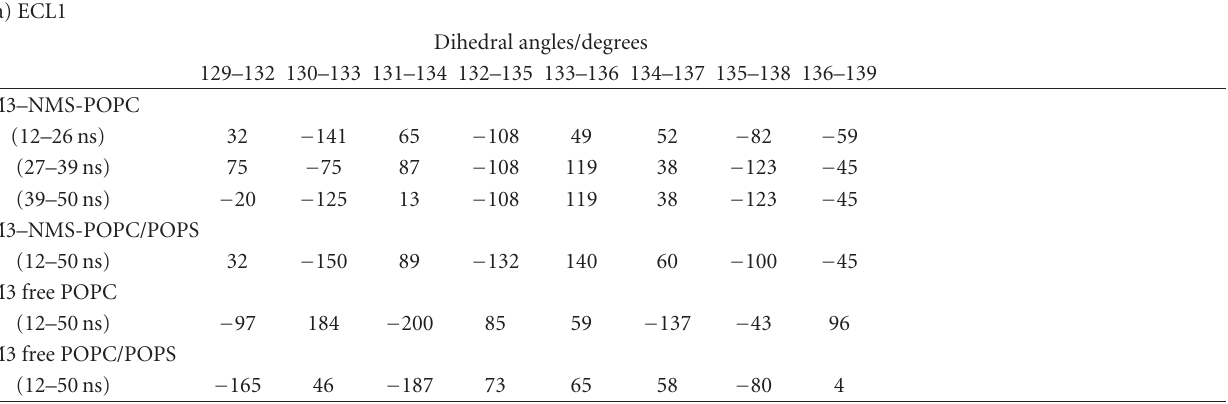
Table 1: Values of the dihedral angles of four consecutive C α alpha carbons corresponding to the three extracellular loops: (a) ECL1, (b) ECL2, and (c) ECL3 of M3R for the four MD trajectories computed in the present